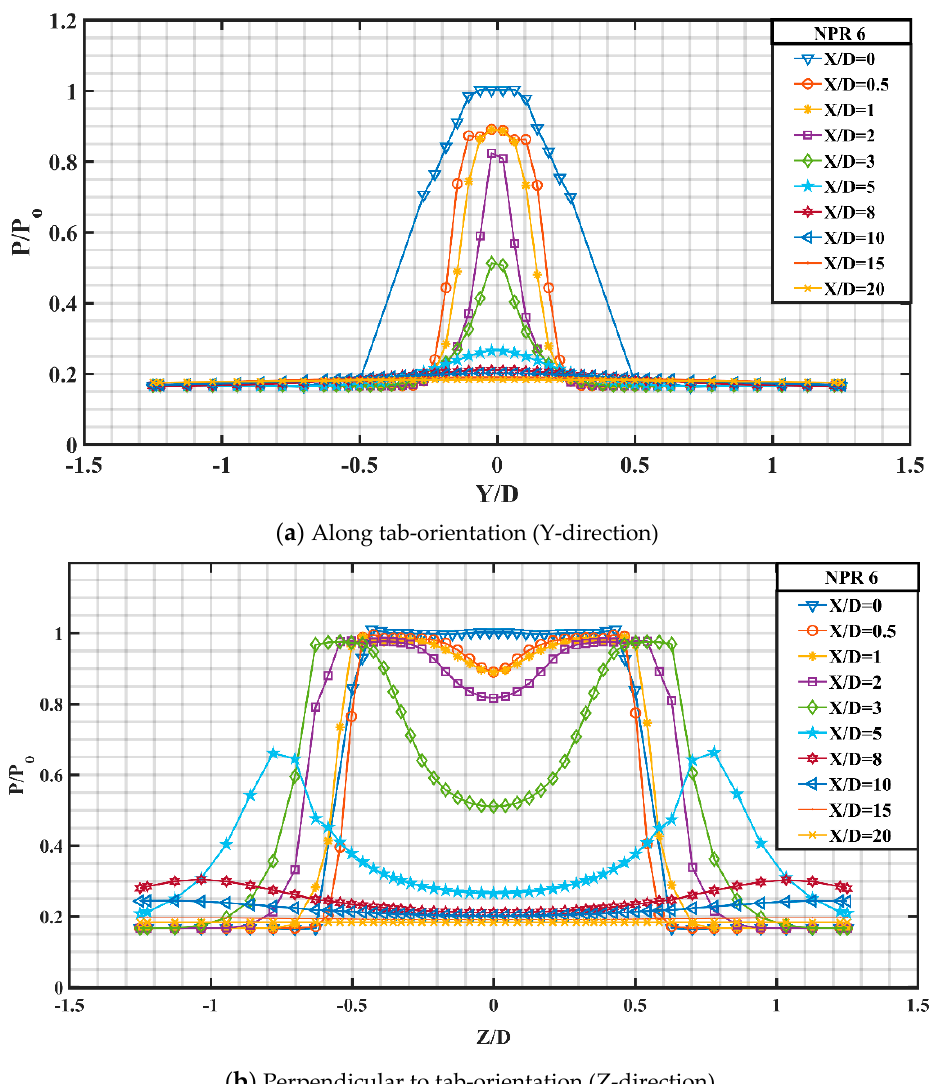
Figure 21. Pressure profile variation for controlled jet at NPR 6.